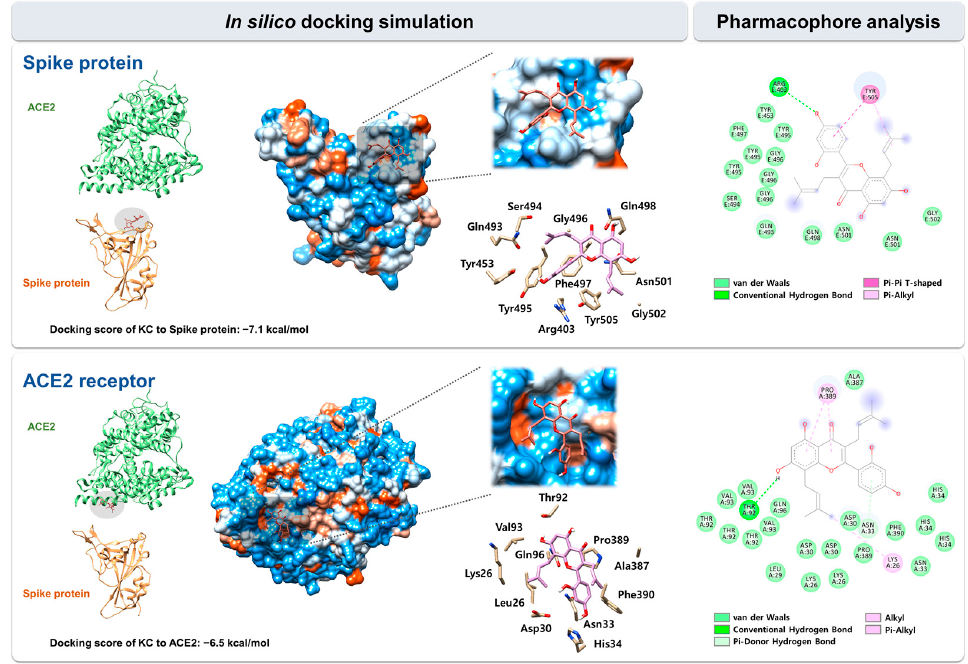
Figure 3. In silico docking simulation between KC and the spike protein/ACE2 receptor. KC was docked onto the SARS-CoV-2 spike protein and ACE2 receptor (PDB code: 6M0J) using AutoDock Vina. The pharmacophore of KC with each target proteins was analyzed using BIOVIA Discovery Studio Visualizer.